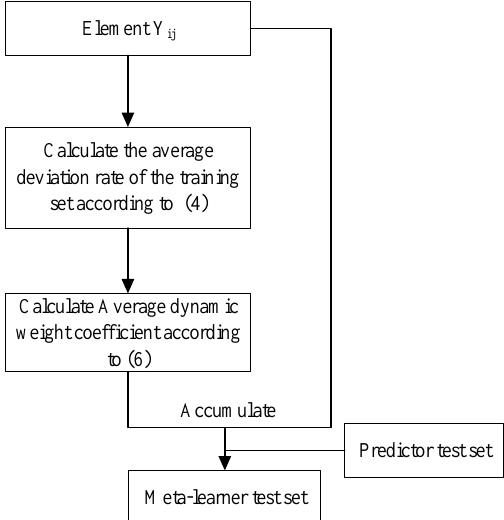
Figure 5. The meta learner training set adjustment process.